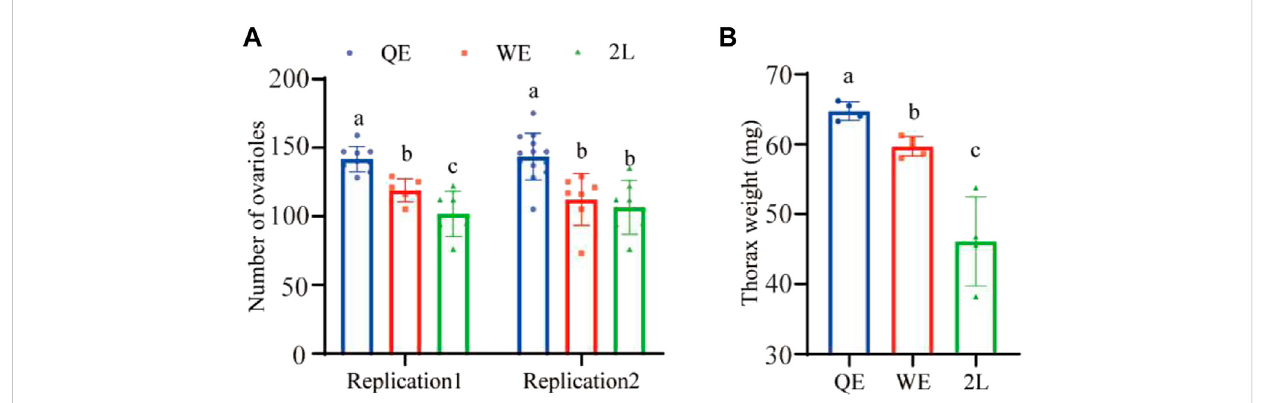
FIGURE 2 (A) Number of right ovarioles and (B) thorax weight of reared queens in the three groups (number of right ovarioles: replication 1, n = 9, 6, 7 for QE, WE,2L,respectively;replication2, n =13,7,7forQE,WE,2L,respectively.Thoraxweight: n =4,5,4forQE,WE,2L,respectively).Thebarsindicatemean± SD (standard deviation). The different letters above the bars indicate signi fi cant differences between groups ( p < 0.05, one-way ANOVA followed by Fisher ’ s LSD test).